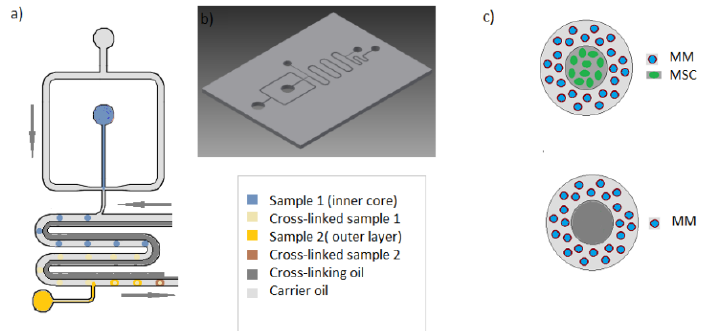
Figure 1. ( a ) Schematic of the double layered hydrogel bead generator. ( b ) Autocad layout of the microfluidic device. ( c ) MM (multiple myeloma) microniche models used. Top: double layered bead containing human multiple myeloma cells in the outer layer and human Mesenchymal stem cells in the inner core. Bottom: double layered bead containing human MM cells in the outer layer and an empty alginate